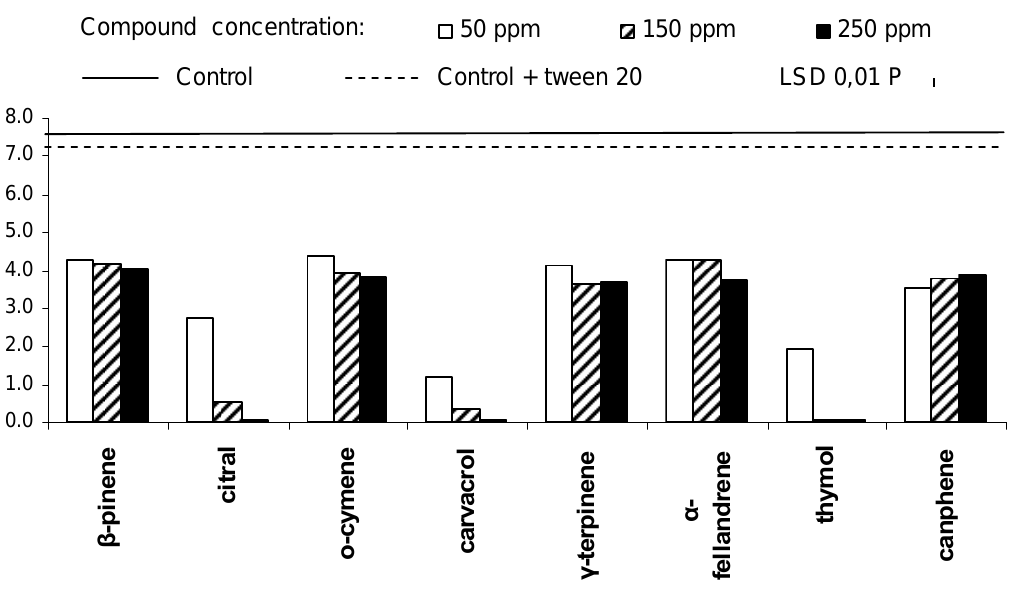
Figure 3. Antifungal activity of the eight plant essential oil components against Botrytis